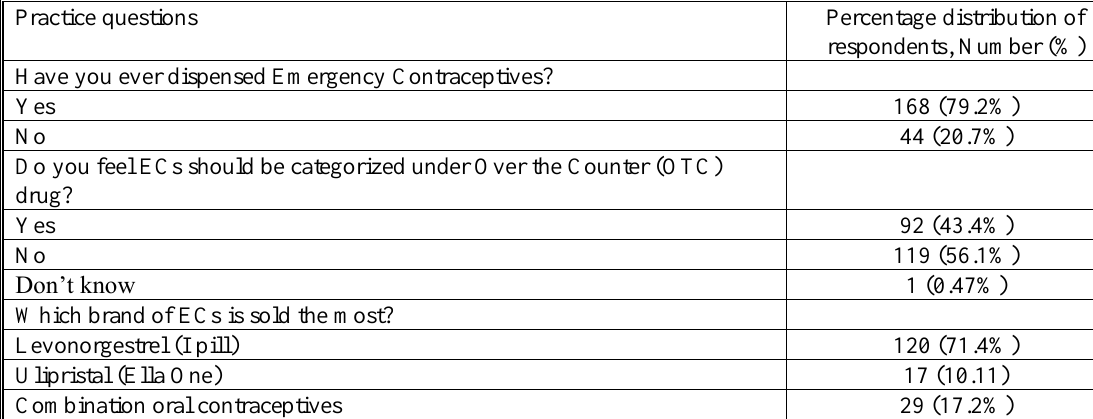
Table 6. The practice of the community pharmacist toward